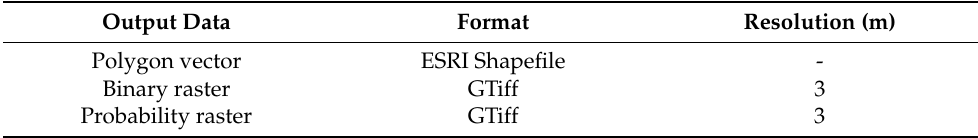
Table 4. List of model inference output data